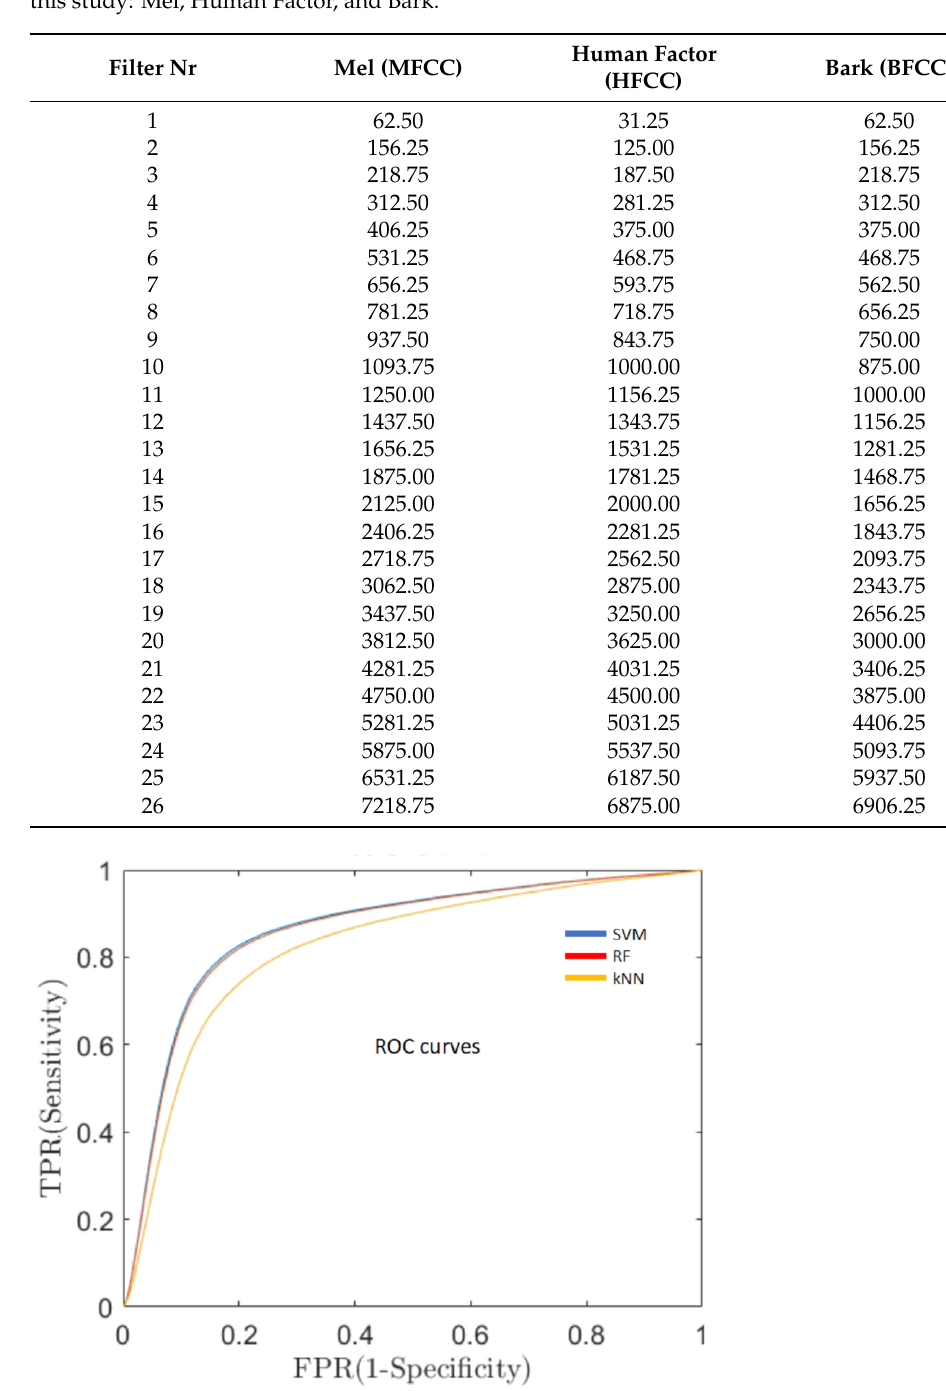
Figure 5. Representation of the receiver operating characteristics (ROC) curve for the three cepstral coefficients (MFCC, HFCC and BFCC) with the best performances. ROC relates the true positive rate (TPR) with the false positive rate (FPR) and the area under the curve (AUC) that measures the degree of separability between the two classes. Blue line represents an SVM with a ν -polynomial kerne, BFCC filter bank. Red line corresponds to an RF, MFCC filter bank. Yellow line corresponds to a kNN, k = 5, MFCC filter bank. 10-fold